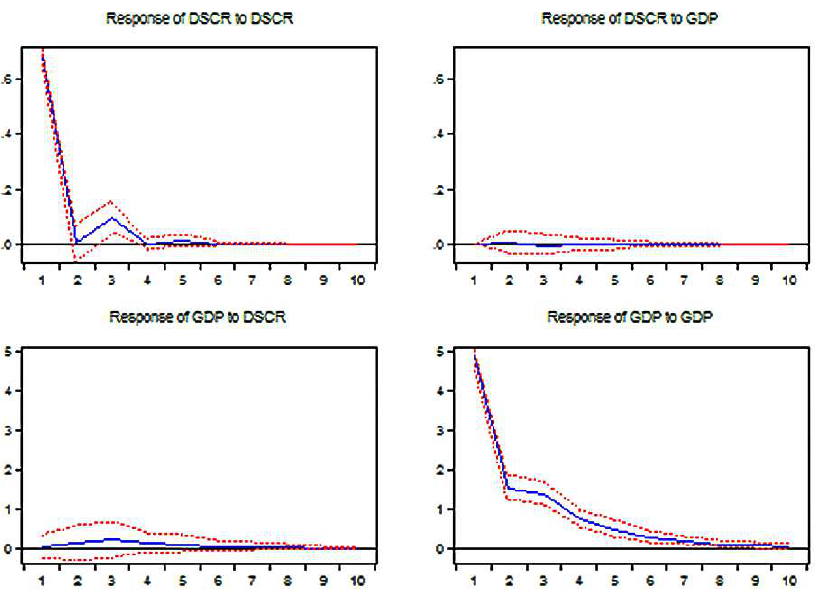
Figure 1. Responses to Cholesky’s one S.D. impulse